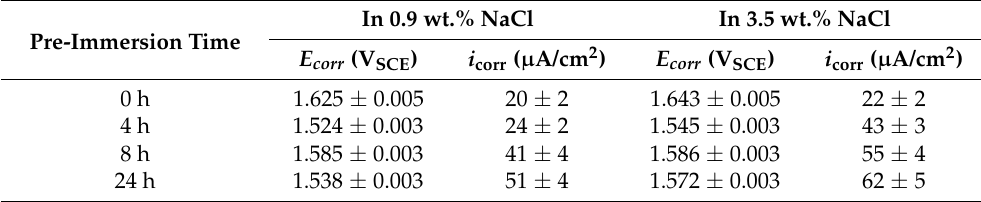
Figure 3. Potentiodynamic polarization curves of samples being pre-immersed in 0.9 wt.% NaCl and 3.5 wt.% NaCl solutions for different time: ( a ) 0 h, ( b ) 4 h, ( c ) 8 h and ( d ) 24 h. Table 2. Fitted results of polarization